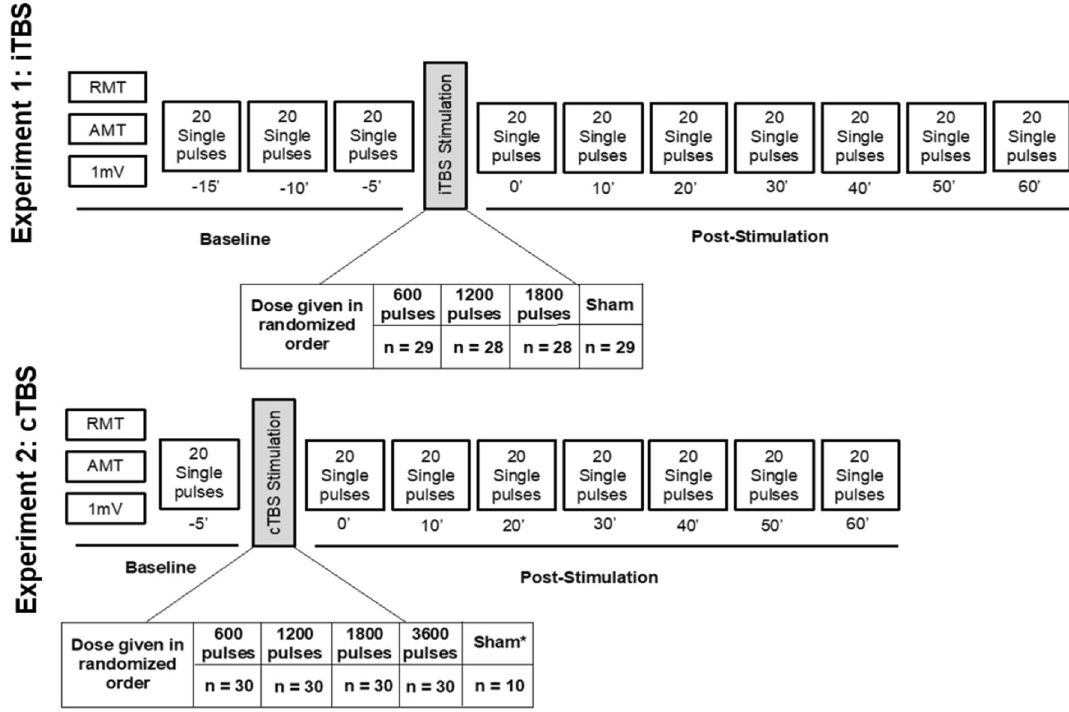
Figure 1. Diagram of experimental design for iTBS and cTBS experiments. This diagram represents the flow of assessments performed on a given visit. Each visit began with resting, active and 1 mV thresholds. Next, 20 baseline MEPs were collected prior to TBS administration (for participants in the iTBS experiment this was performed 3 times). A dose of iTBS or cTBS was administered at 80% aMT. Directly following stimulation 20 MEPs were collected and repeated at 10-min intervals thereafter. Only a subset of participants during Experiment 2 received sham